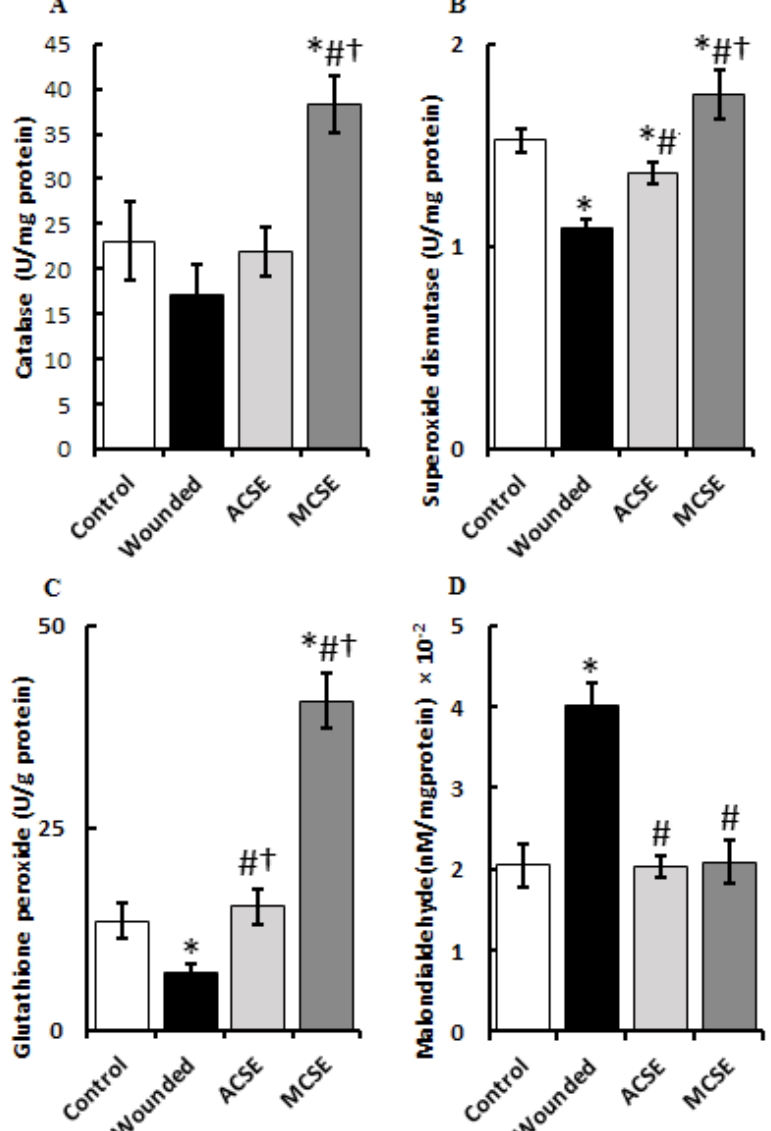
Figure 1: Catalase, superoxide dismutase and glutathione peroxidase activities and malondialdehyde in wound tissues following treatment with corn silk extracts.ACSE, aqueous corn silk extract; MCSE, methanolic corn silk extract. Bars indicate mean±SEM (n = 5); *, #, and †indicate significant difference at p<0.05 as compared with control, wounded and ACSE